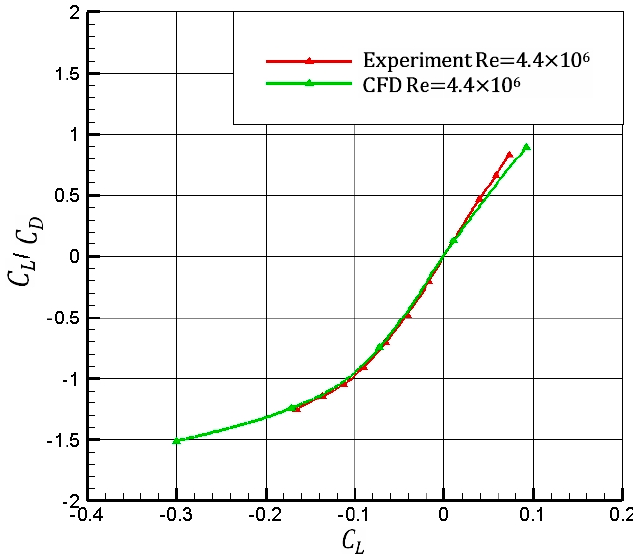
Figure 2. Computational Fluid Dynamics (CFD) and experimental drag coefficients vs. lift coefficient for Ansat-P model.